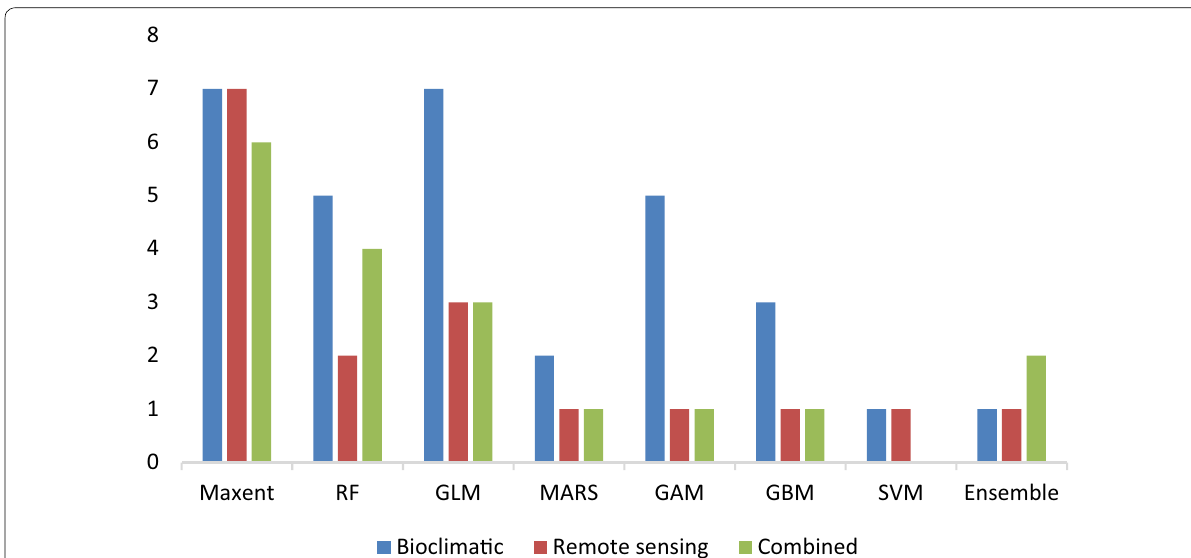
Fig. 6 Species distribution models (SDM) and their use of bioclimatic, remote sensing, and combined data. Maxent, GLM, MARS, GAM, and GBM use presence-only data whereas RF and SVM use both presence and absence data